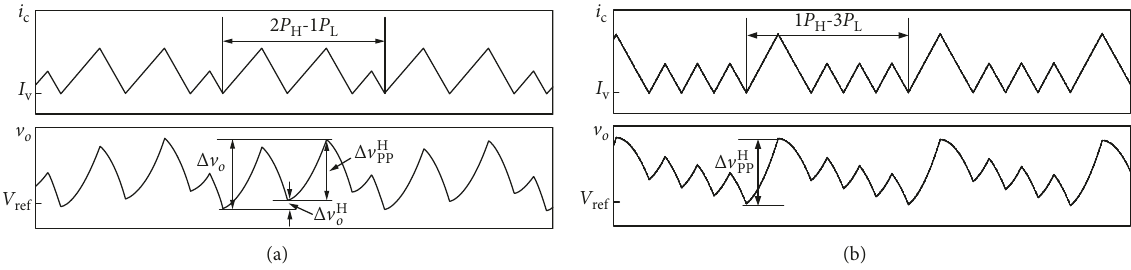
H -1 P L . (b) The case of 1 P H -3 P L .